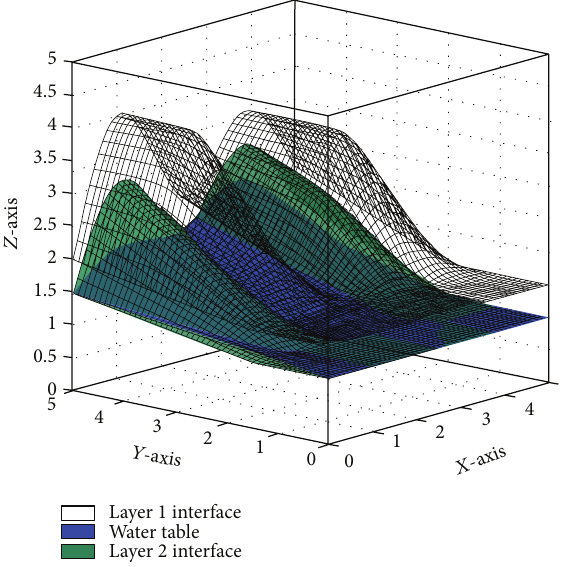
Figure 6: Generated slope model for sensitivity analysis.